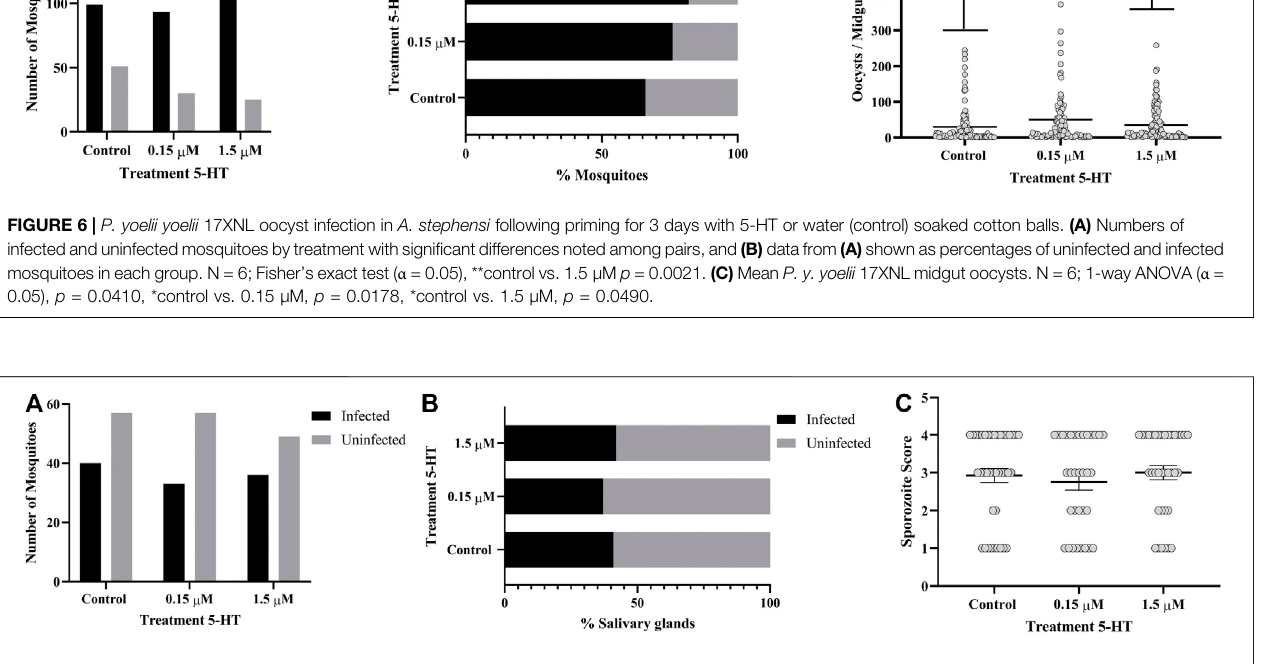
FIGURE 7 | P. yoelii yoelii 17XNL salivary gland infection in A. stephensi following priming for 3 days with 5-HT or water (control) soaked cotton balls. (A) Numbers of mosquitoes with infected and uninfected salivary gland pairs and (B) data shown as percentages of uninfected and infected mosquito salivary gland pairs in each group. N = 6; Chi-squared test ( α = 0.05), no signi fi cance. (C) Mean salivary gland score. N = 6; one-way ANOVA ( α = 0.05), no signi fi